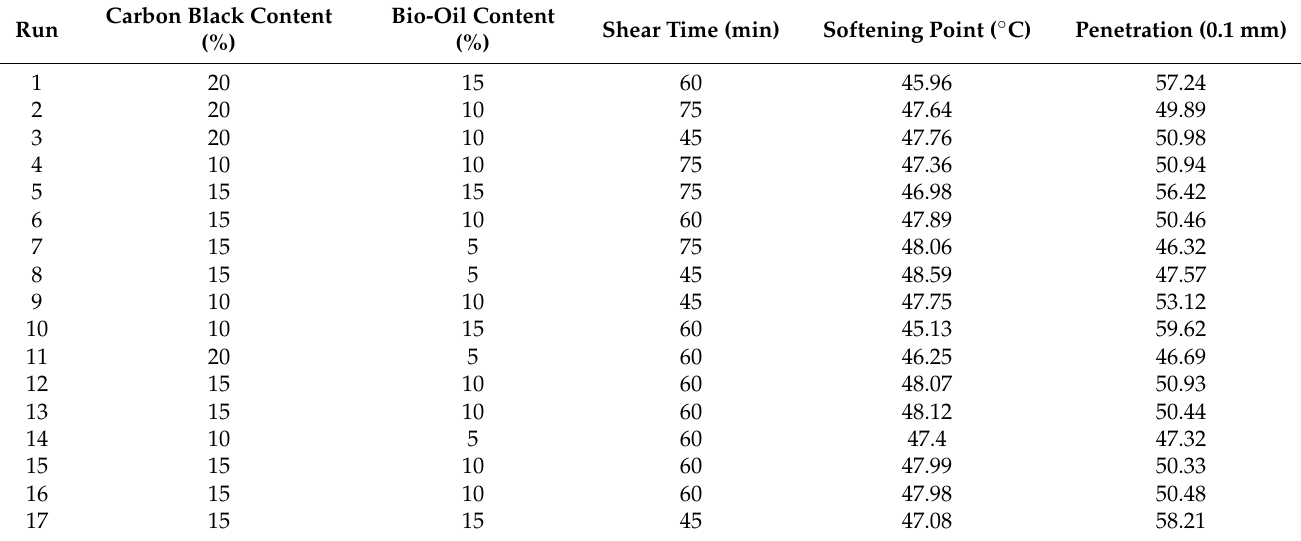
Table 5. Average value of the softening point and penetration test